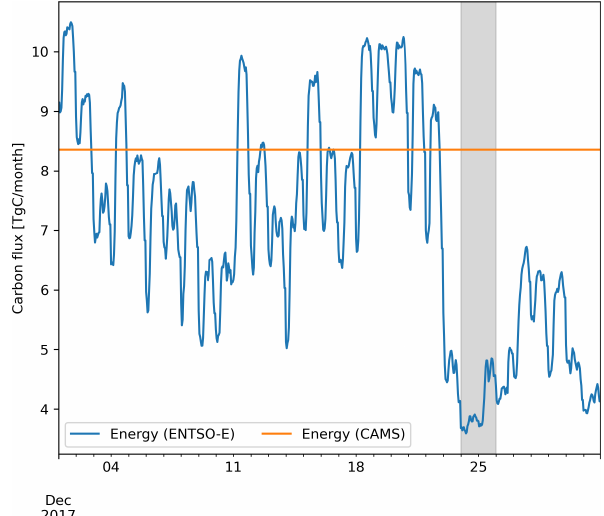
Figure A1. CO 2 emission from the energy sector, according to the ENTSO-E reported data and CTE-HR (blue line) and the CAMS- REG-GHG dataset (green line) over Germany for December 2017. The grey area indicates the period in which the negative energy prices